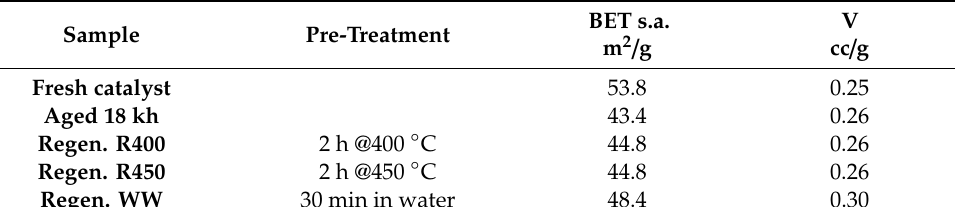
Table 2. BET surface area and volume of pores of fresh, aged and regenerated selective catalytic reduction (SCR) catalysts.